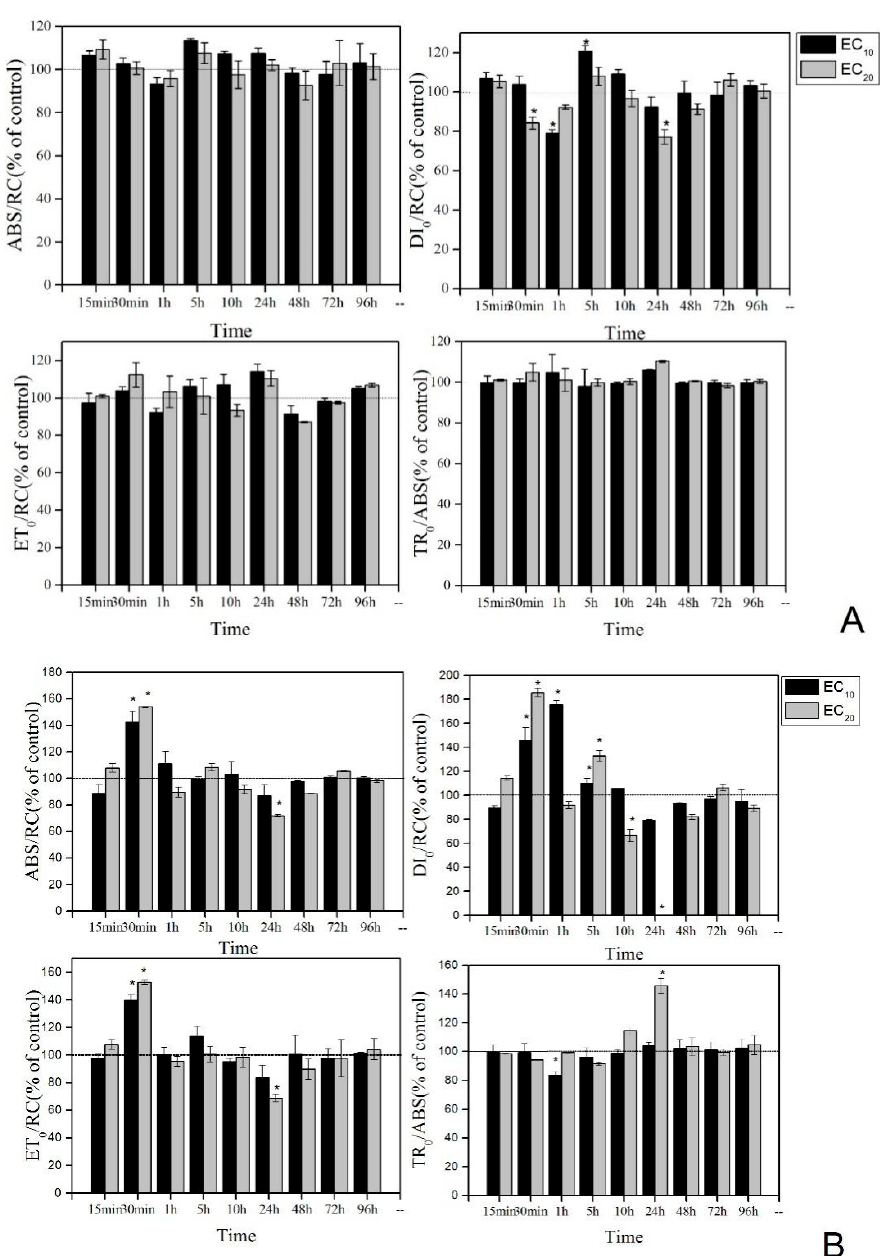
Figure 4. OJIP test parameters expressed as a percentage of the control when C. vulgaris ( A ) and P. tricornutum ( B ) were treated with EC 10 and EC 20 of La(NO 3 ) 3 · 6H 2 O and dark-adapted for 15 min. *Significant difference compared with the control ( p < 0.05).